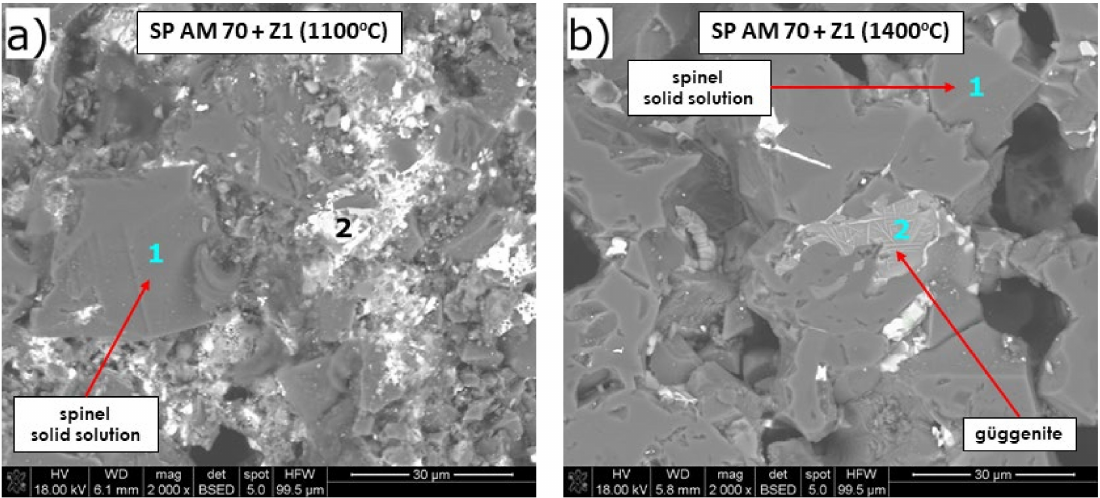
Figure 10. SEM images of fused spinel SP AM 70 after pellet test at 1100 ◦ C ( a ) and 1400 ◦ C ( b ). Table 9. EDS analysis in microareas of mixture PAK + slag after corrosion, in the points marked in Figure 10, together with corresponding phases. Figure No. Spinel MgAl 2 O 4 s.s. Figure 10a Spinel MgAl 2 O 4